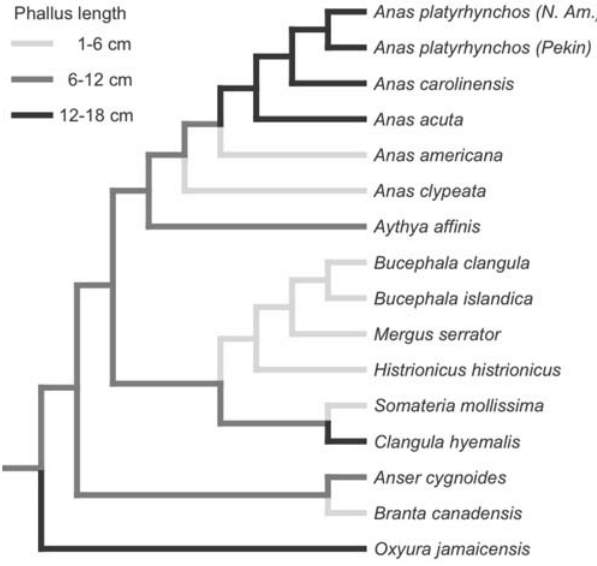
Figure 4. Hypothesis of the phylogenetic pattern of evolution in phallus length, based on the phylogeny proposed in Fig. S1, using the minimized squared change parsimony algorithm in MacClade, and three size classes (1–6 cm, 6–12 cm, and 12–18 cm). Phallus length . 12 cm has evolved three times independently within these waterfowl- in Oxyura, Clangula , and Anas. All three of these lineages show correlated evolution of anatomical counter measures in the female reproductive